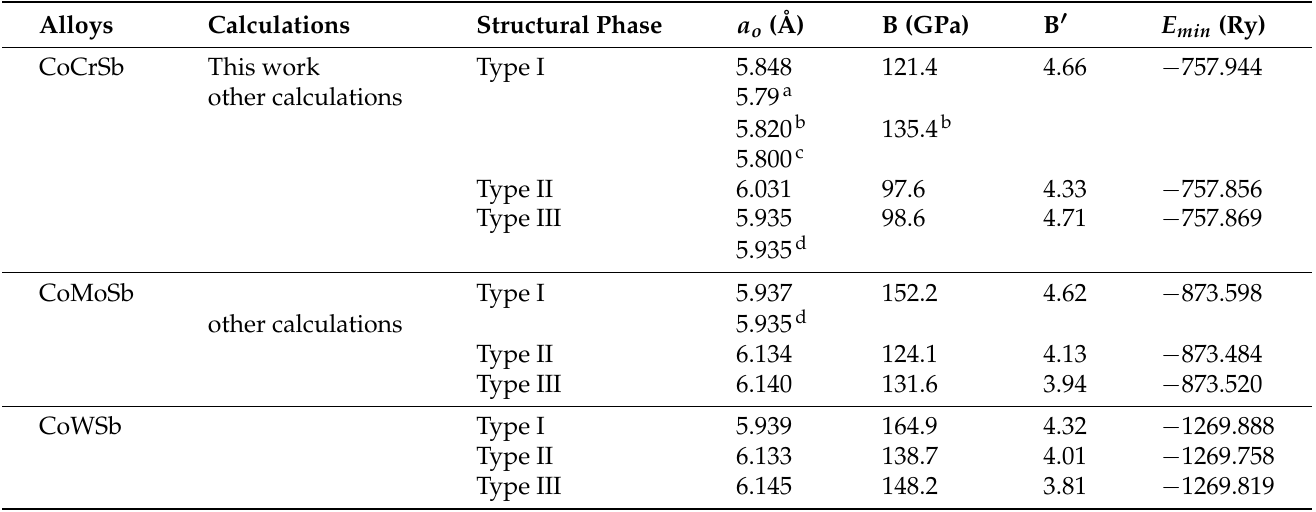
Table 2. The optimized lattice constants, a o (Å), equilibrium energies, E min (Ry), bulk modulus, B (GPa), and pressure derivative for the bulk modulus, B (cid:48) for CoYSb (Y = Cr, Mo, W) for the three possible structural phases.